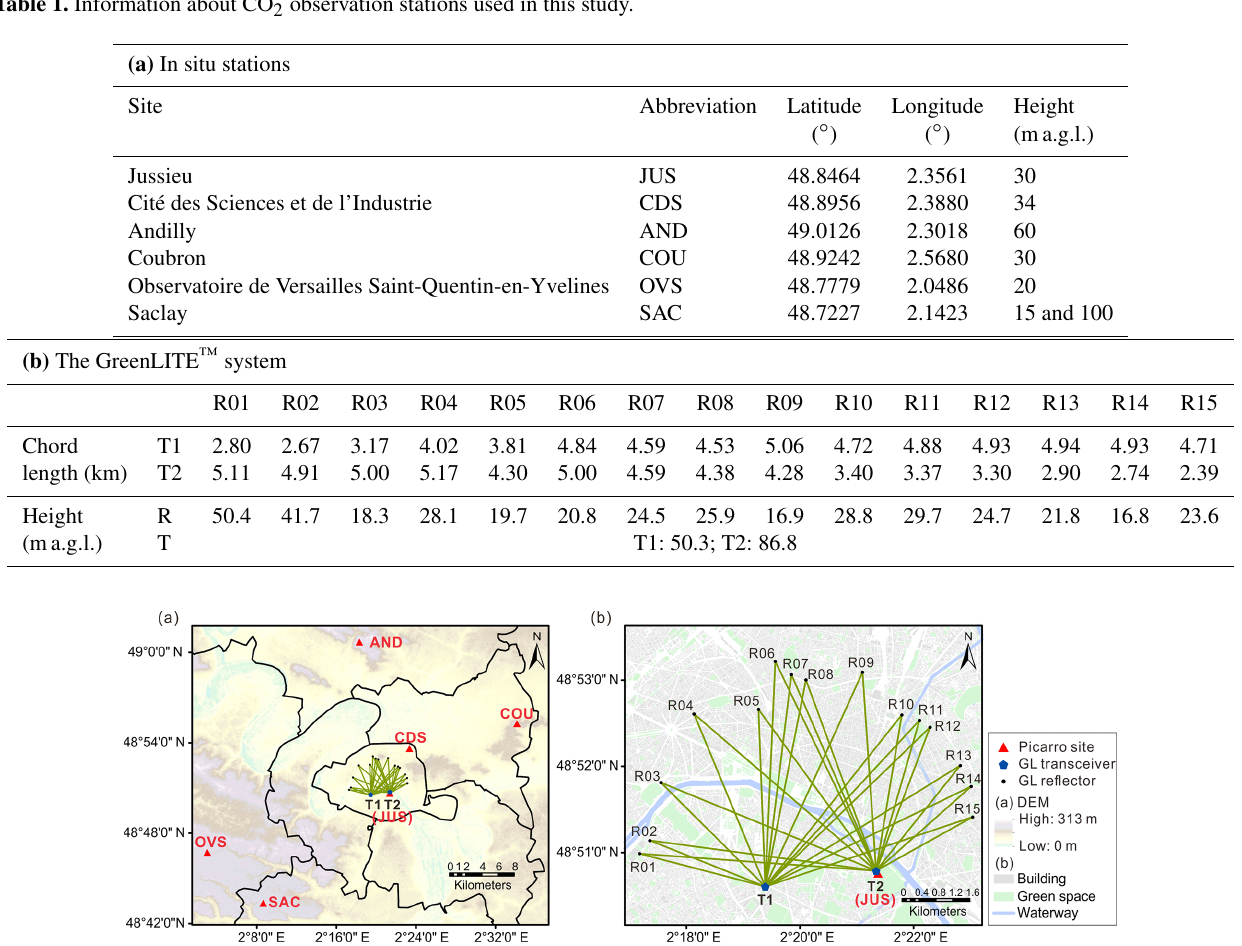
Table 1. Information about CO 2 observation stations used in this study.